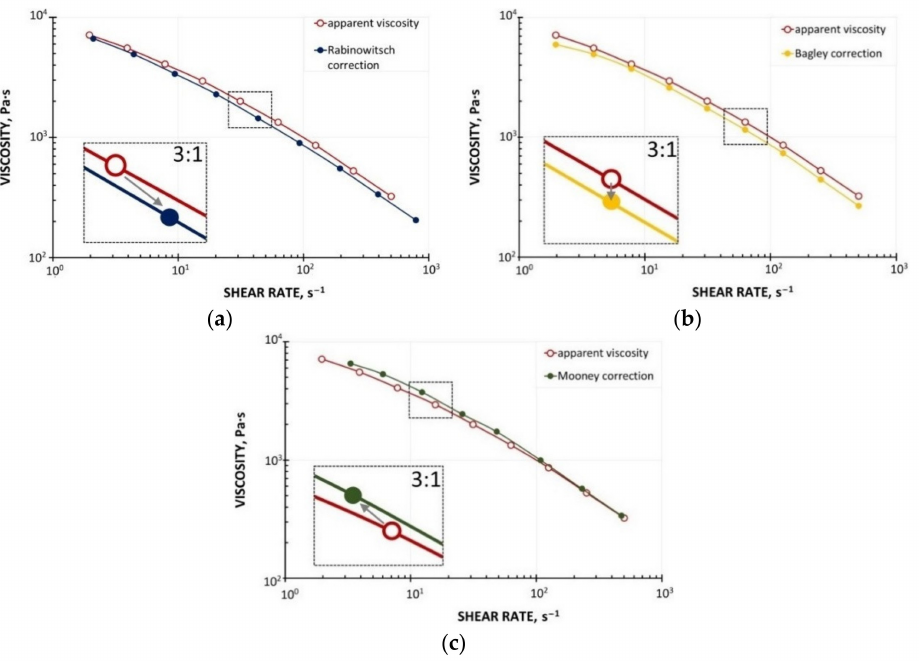
Figure 4. Effect of rheometric corrections on viscosity curves (PP copo inj 4, Beologic): ( a ) Rabinowitsch correction, ( b ) Bagley correction, ( c ) Mooney